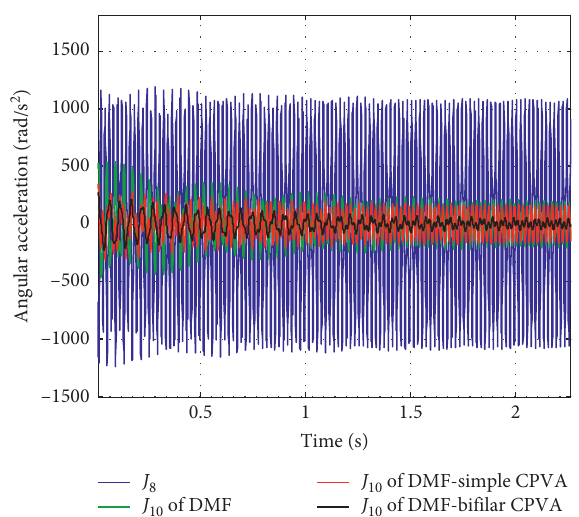
8 and J 10 at 2500r/min